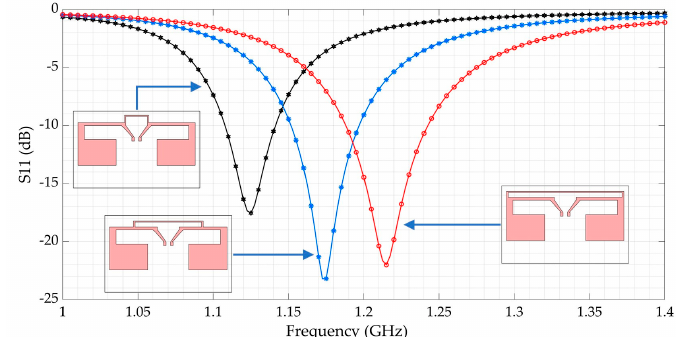
Figure 4. Simulated S11 (return loss) of the antenna for different configurations; L = 10 mm (black), L = 30 mm (blue) and L = 51.4 mm (red).